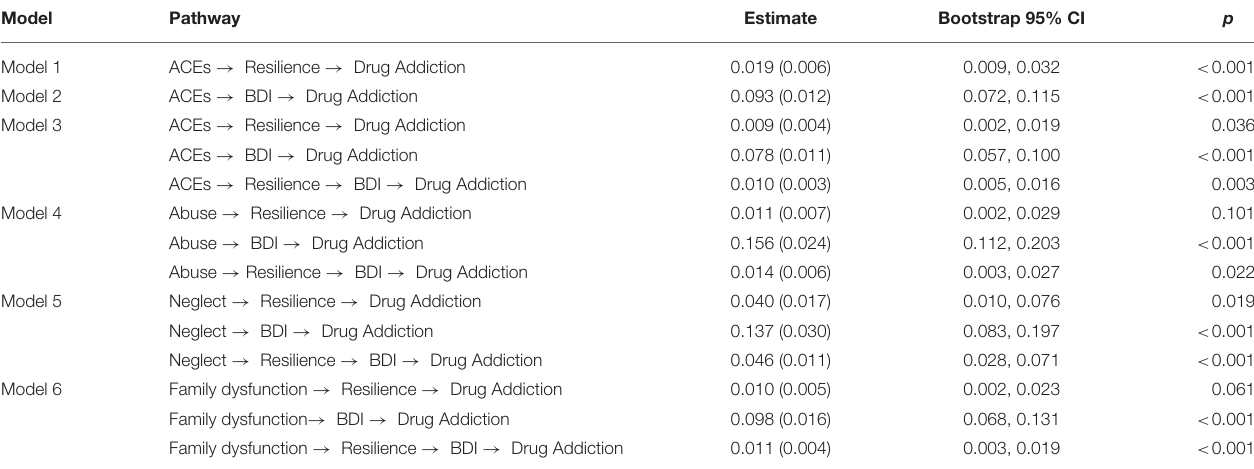
TABLE 3 | Indirect effects with bootstrap 95%